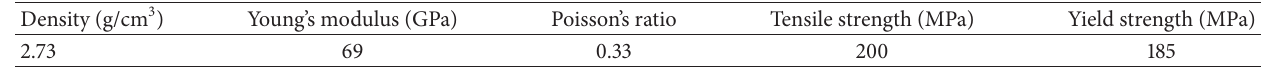
Table 2: Physical and mechanics properties of aluminium alloy